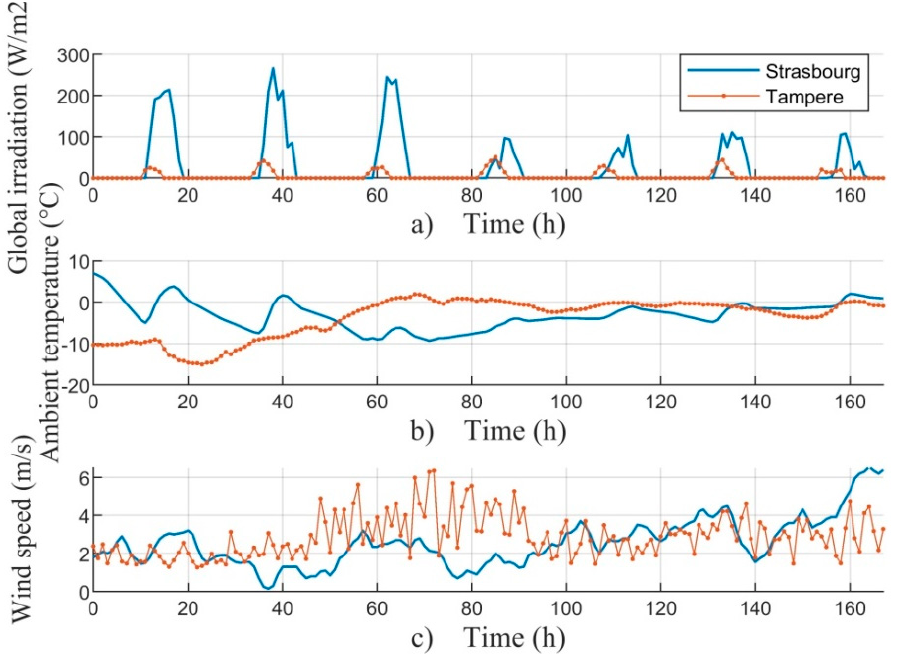
Figure 3. Climate conditions during the winter week in Tampere and Strasbourg: ( a ) solar irradiation; ( b ) ambient temperature; ( c ) wind speed.